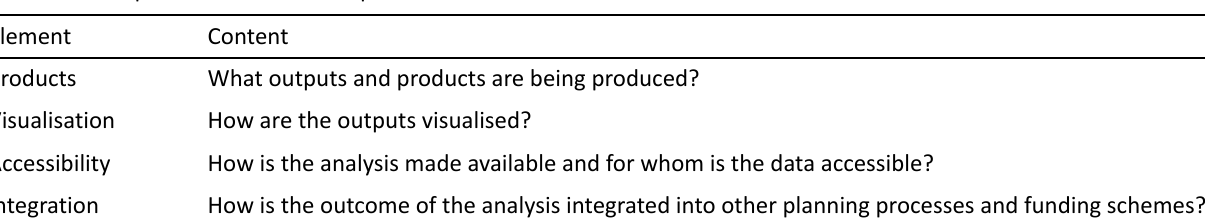
Table 2. Conceptualisation of the